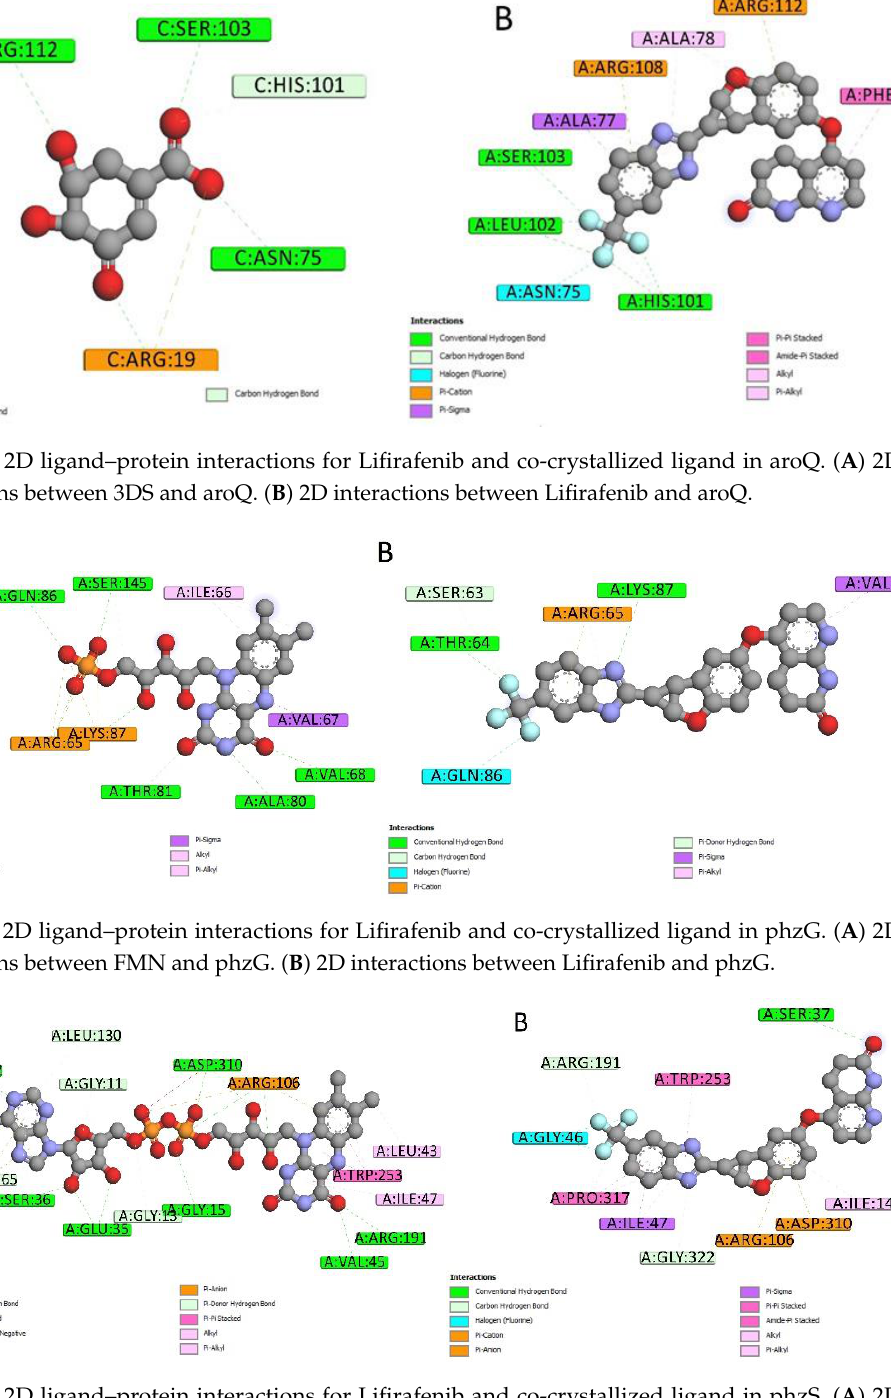
Figure 7. 2D ligand–protein interactions for Lifirafenib and co-crystallized ligand in phzS. ( A ) 2D interactions between FAD and phzS. ( B ) 2D interactions between Lifirafenib and phzS.